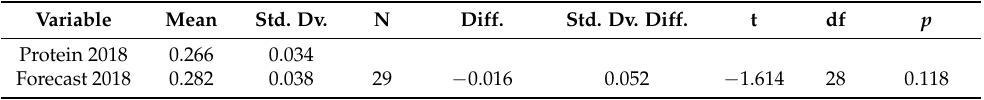
Table 6. T -test for dependent samples between real and forecast values of airborne protein concentra- tions in 2018. Marked differences are significant at p <